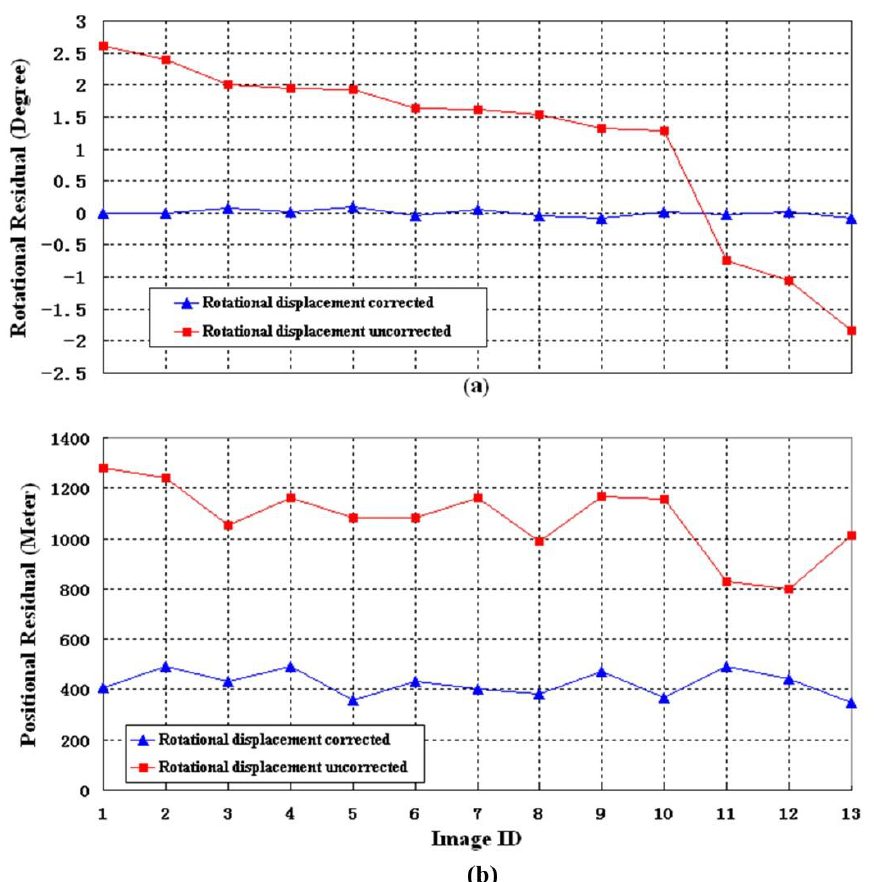
Figure 8. ( a ) Rotational residual and ( b ) geolocation residual of corner points of the images acquired by ISSAC onboard the ISS before and after the correction of drift angle effect. The images are sequenced by the latitude of its ground nadir